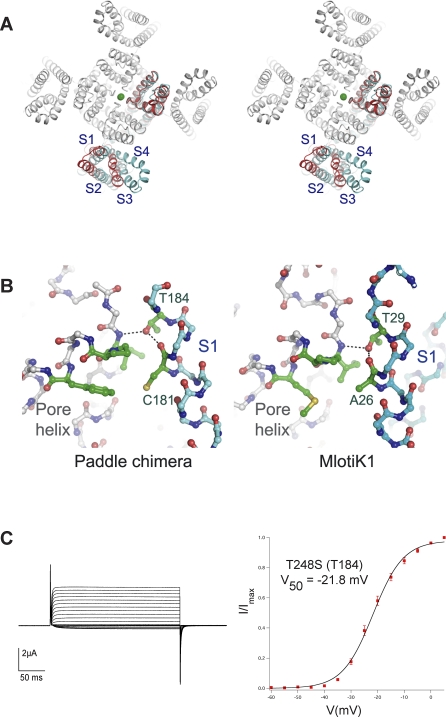
Chemistry of Interaction at the S1–Pore Interface(A and B) Comparison of the S1–pore interface between paddle chimera (PDB ID: 2R9R) and MlotiK1 (PDB ID: 3BEH). (A) Stereoview of superposition of the paddle chimera (cyan) and MlotiK1 (red) structures viewed from the extracellular side. Superposition was done using residues 337–344, 359–389 in paddle chimera, and the corresponding residues 142–149 and 164–194 in MlotiK1.(B) Close-up view of the S1–pore interfaces. Pore helices are shown in gray and S1 helices are shown in cyan. Co-evolved residues (green) are shown in ball-and-stick representation.(C) Voltage-dependent gating properties of T248S Shaker. The corresponding residue in Kv1.2 is denoted in parentheses. On the left are shown families of ionic currents at 5-mV increments, and on right, the normalized currents are fitted to a two-state Boltzmann. The holding voltage was −80 mV, tail voltage was −60 mV.